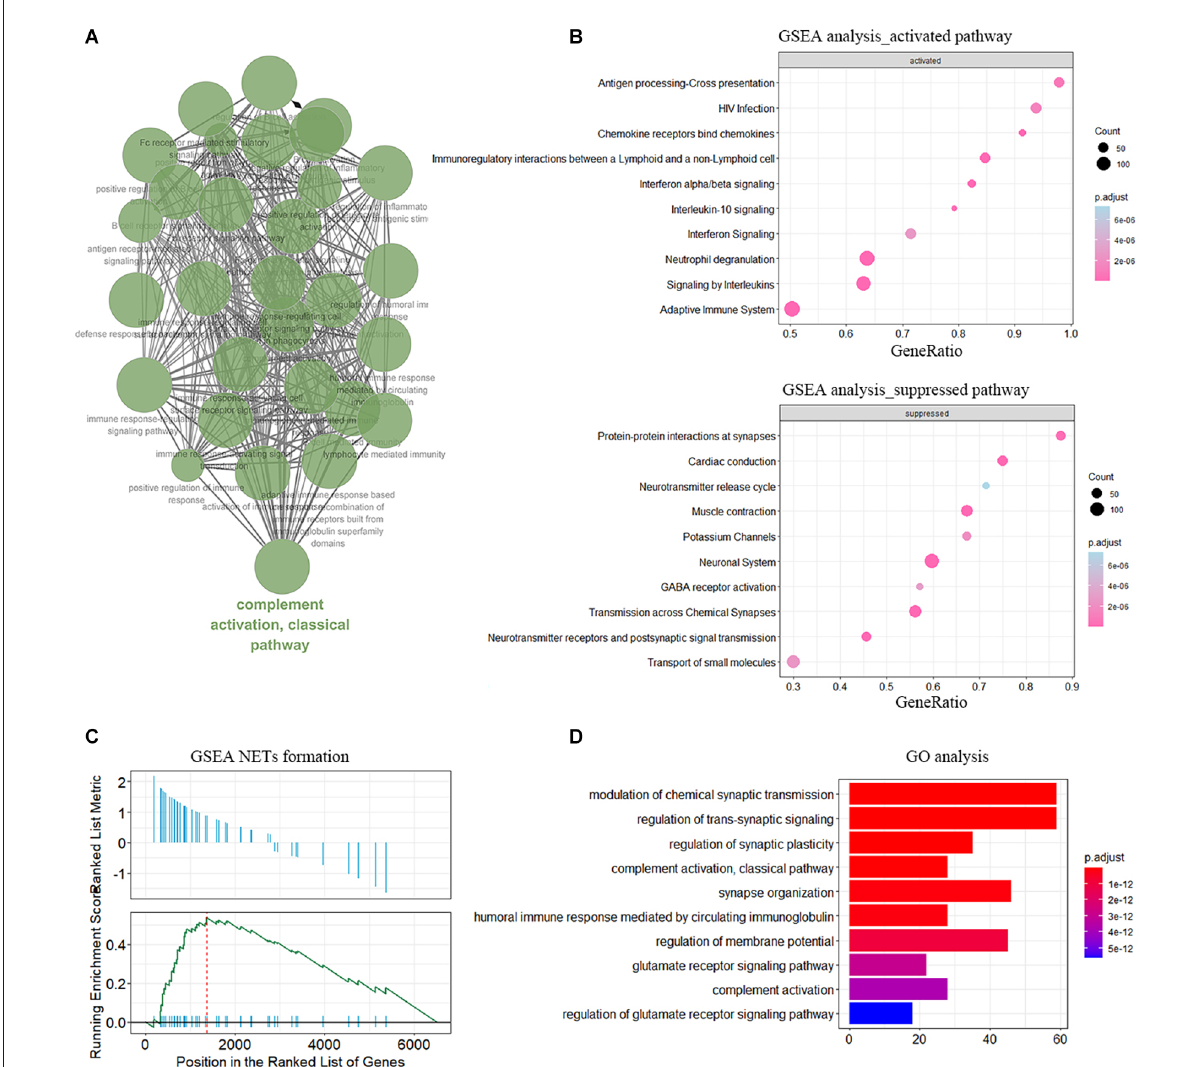
FIGURE2 Functional enrichment of DEGs in sample of arterial samples dataset. (A) The interaction networks of enriched biological processes analyzed by ClueGO. (B) GSEA showing the enriched pathway in neutrophile degranulation. (C) Enrichment of NETs formation term analyzed by GSEA. (D) GO enrichment analysis in the aSAH blood